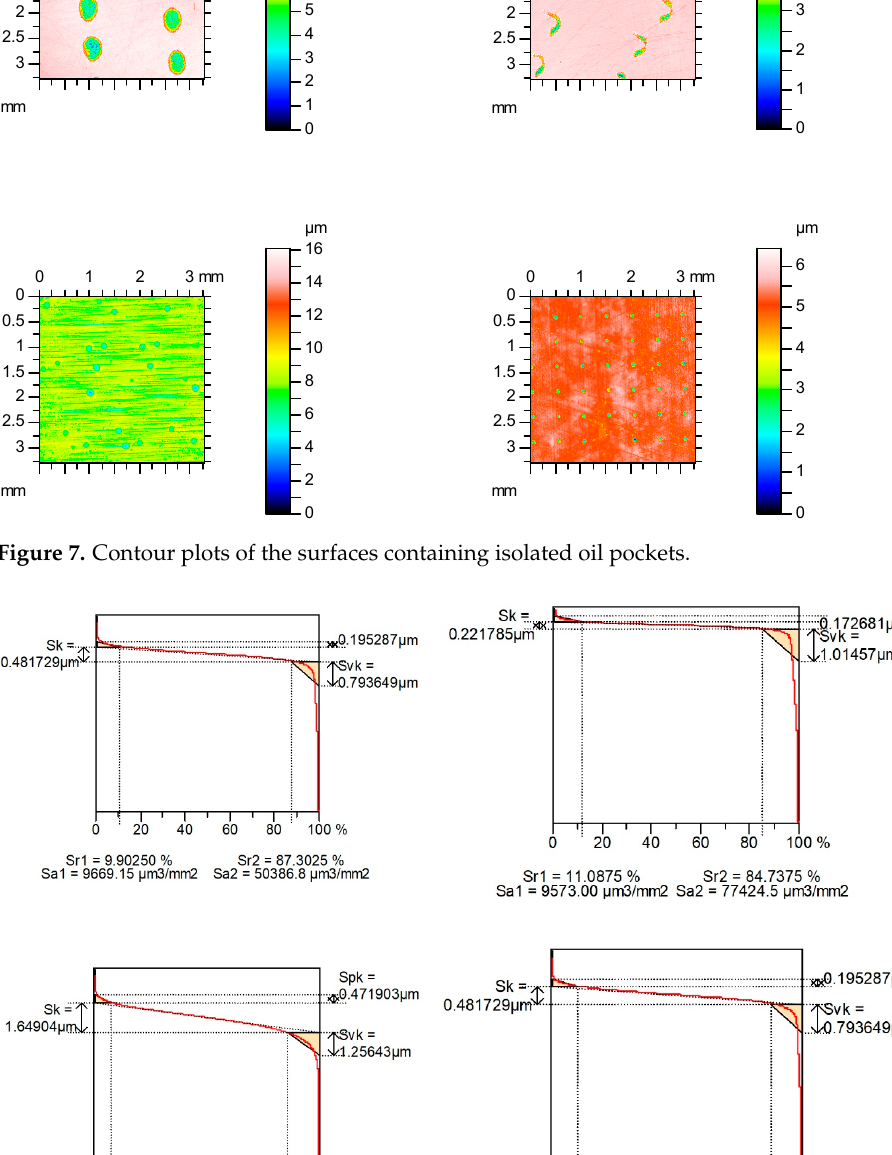
Figure 8. Material ratio curves of surfaces shown in Figure 7.